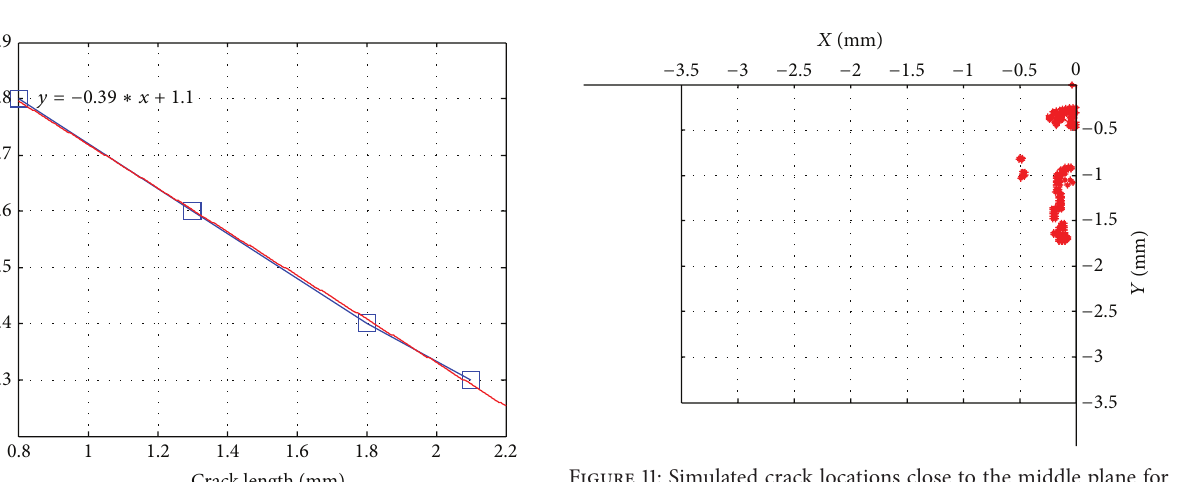
Figure 11: Simulated crack locations close to the middle plane for samples processed with small